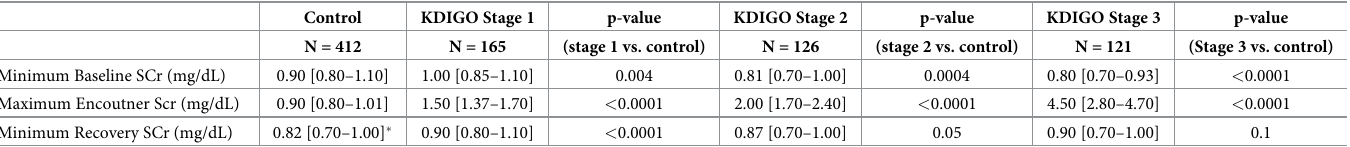
Table 2. Serum creatinine values during study period and AKI by KDIGO stage.